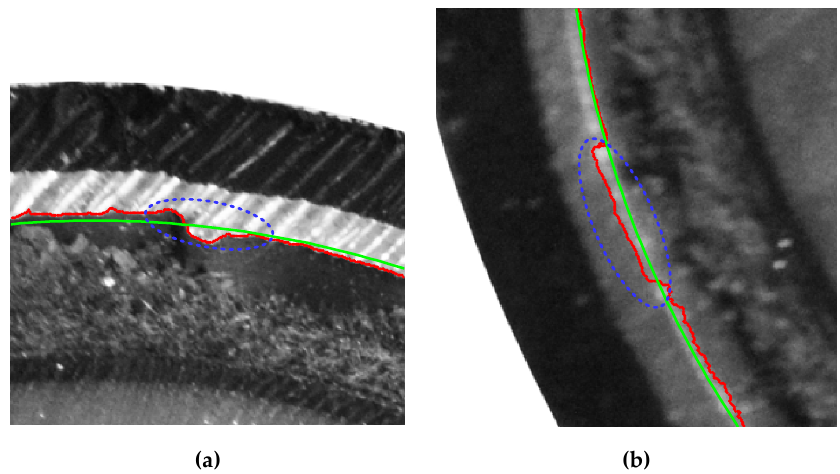
Figure 6. Fluctuations in initial contour C k , in which red dots are contour points, green line denotes the Figure 6 . Fluctuations in initial contour (cid:1829) (cid:3038) , in which red dots are contour points, green line denotes fitted circular contour C ck , and fluctuations exist in blue ellipse. ( a ) Structure-related gentle changes; the fitted circular contour (cid:1829) (cid:3030)(cid:3038) , and fluctuations exist in blue ellipse. (a) Structure-related gentle ( b ) Mutations with steep changes; (b) Mutations with steep changes.